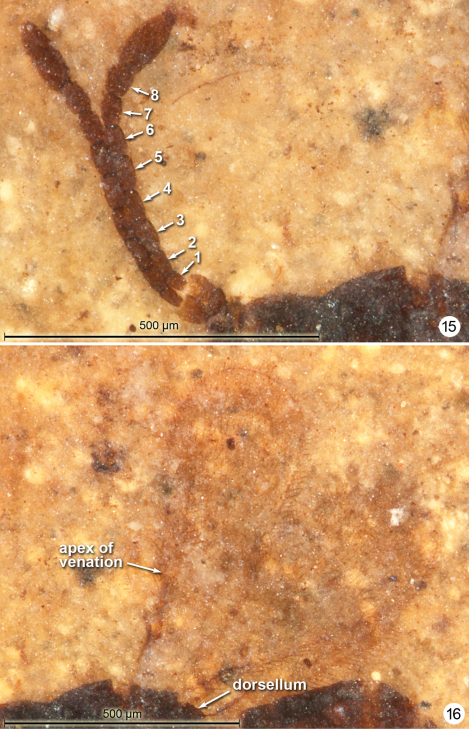
Gonatocerus greenwalti holotype: antennae 16 wings.